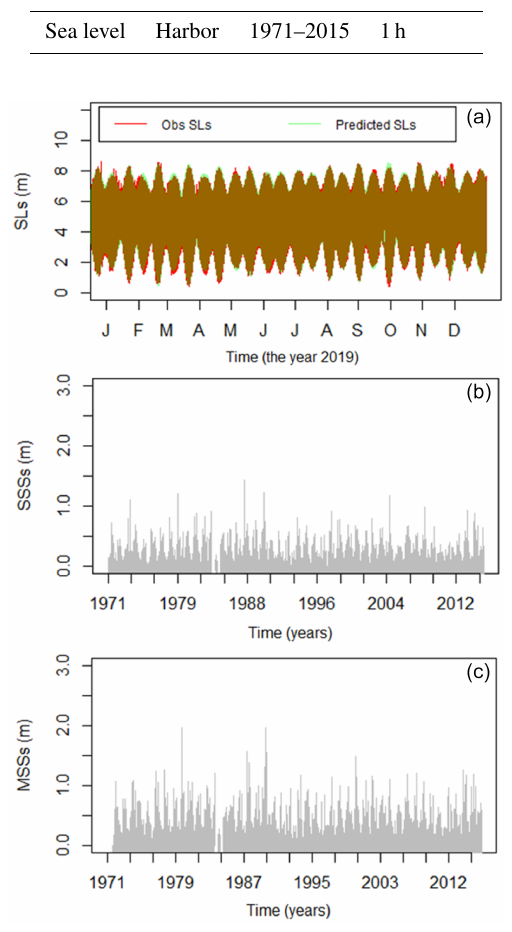
Figure 4. Studied time series of Le Havre: (a) predicted and ob- served sea levels; (b) SSS data and (c) the MSSs.